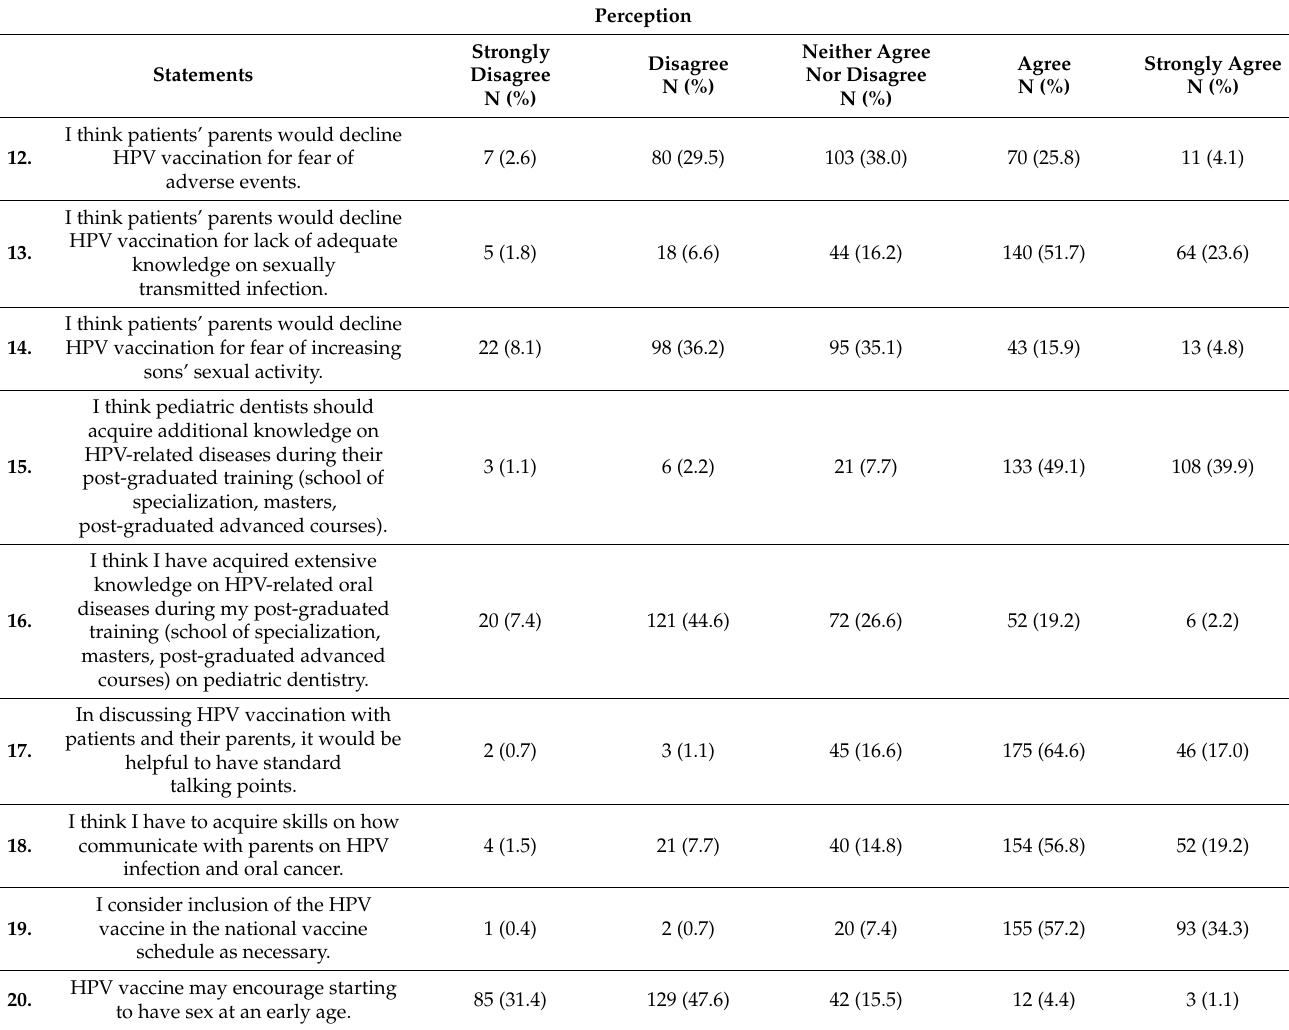
Table A5. Survey responses assessing pediatric dentists’ attitude on HPV-related OP-cancer, HPV infection, and HPV vaccine. Each of these statements can be answered on a five-points